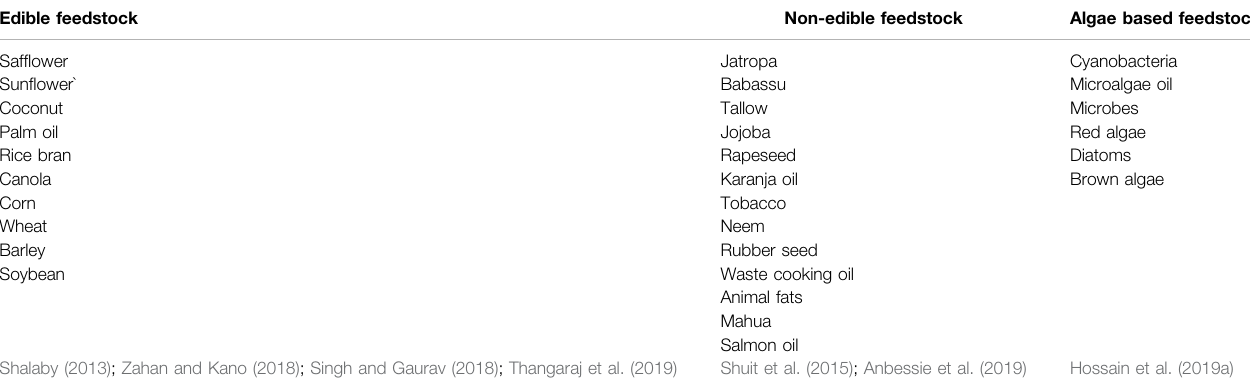
TABLE 1 | Different types of feedstock used in biodiesel production. Edible